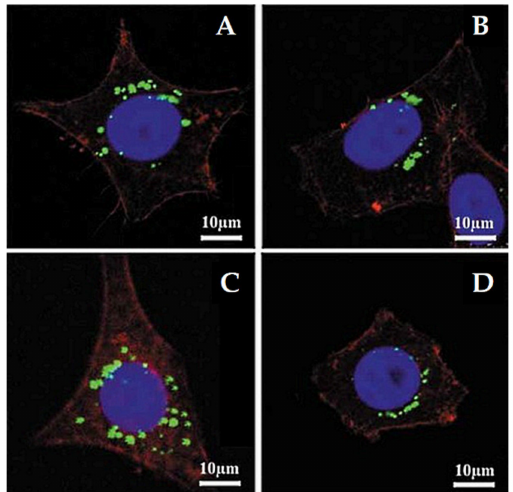
Figure 7. Confocal laser microscopy images of HeLa cells after incubation with different sizes of MSNs labeled with fluorescein isothiocyanate (FITC) green fluorescence (MSN-FITC) (100 µ g mL − 1 , green) for 5 h at 37 ◦ C. ( A ) 170 nm, ( B ) 110 nm, ( C ) 50 nm, and ( D ) 30 nm. The cell skeleton was stained with rhodamine-phalloidin (red), and the cell nucleus with 4 (cid:48) ,6-diamidino-2-phenylindole (DAPI; blue). Reproduced with permission from [103], WILEY-VCH Verlag GmbH and Co. KGaA, 2009.